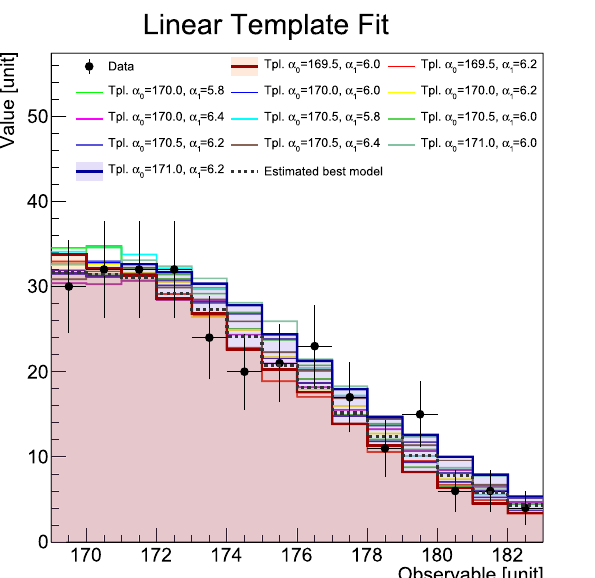
Fig. 2 Two views of the template matrix Y of an example application of the multivariate Linear Template Fit. Left: the template distributions Y as a function the observable. More details are given in the caption of Fig. 1. Right: the template distributions Y (open medium-sized circles)